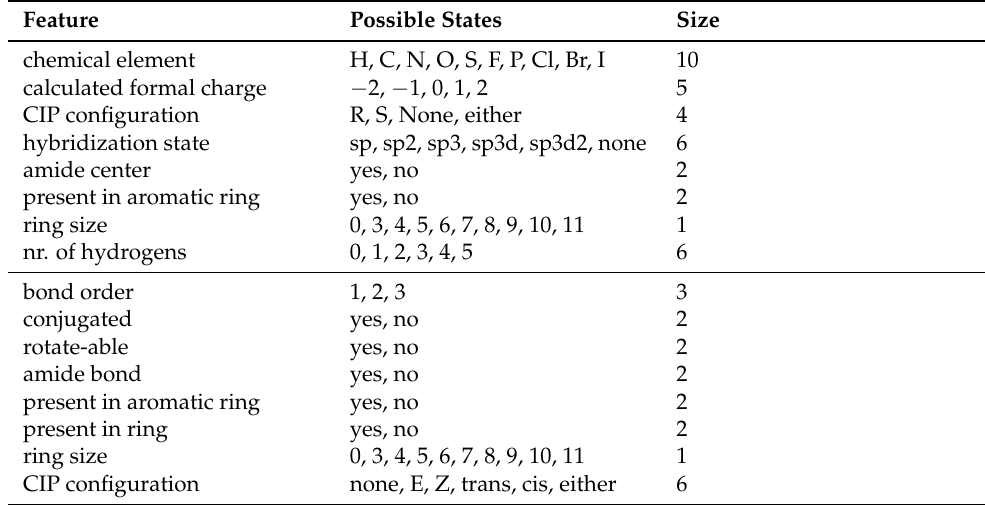
Table A2. Node and edge featurization of type 4. Each node or edge featurization vector consisted of a concatenation of the different one-hot encoded or floating point feature vectors according to their possible states (if present) and corresponding size-45 for nodes and 29 for edges.